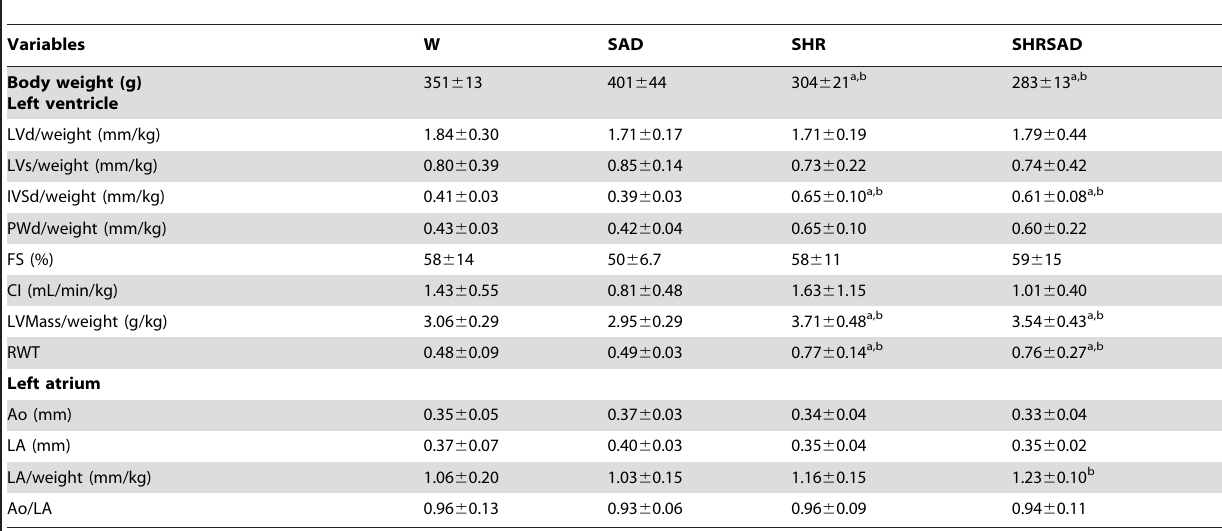
Table 5. Cardiac morphology obtained by M-mode transthoracic echocardiography.